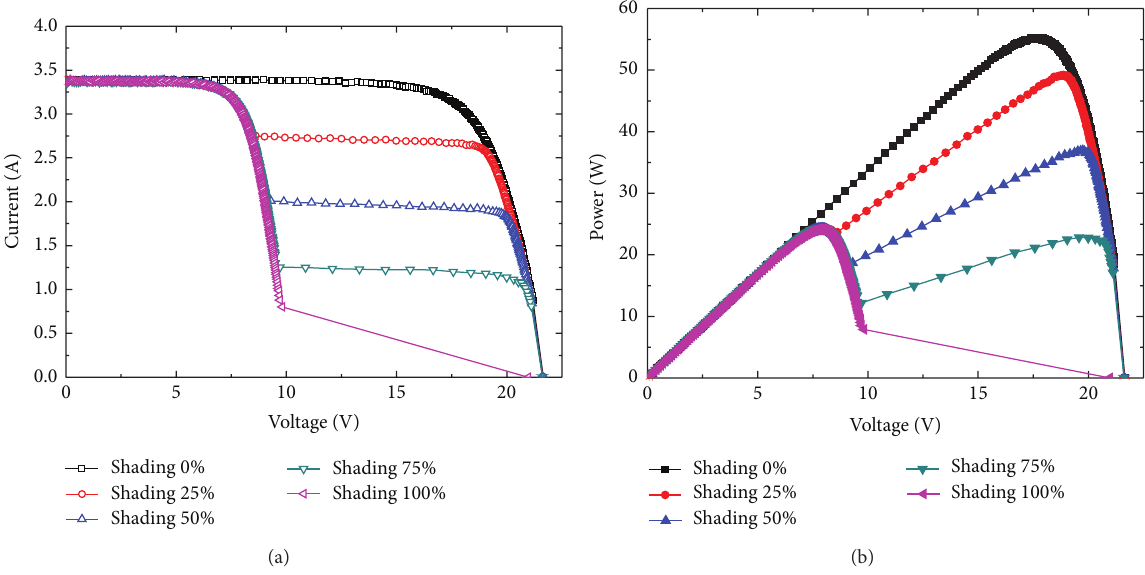
Figure 2: The output characteristics of KC50T-1 PV Module under 0%, 25%, 50%, 75%, and 100% shading on a single solar cell in one of the two groups which are parallel connected with two bypass diodes. (a) I-V curves and (b) P-V curves.